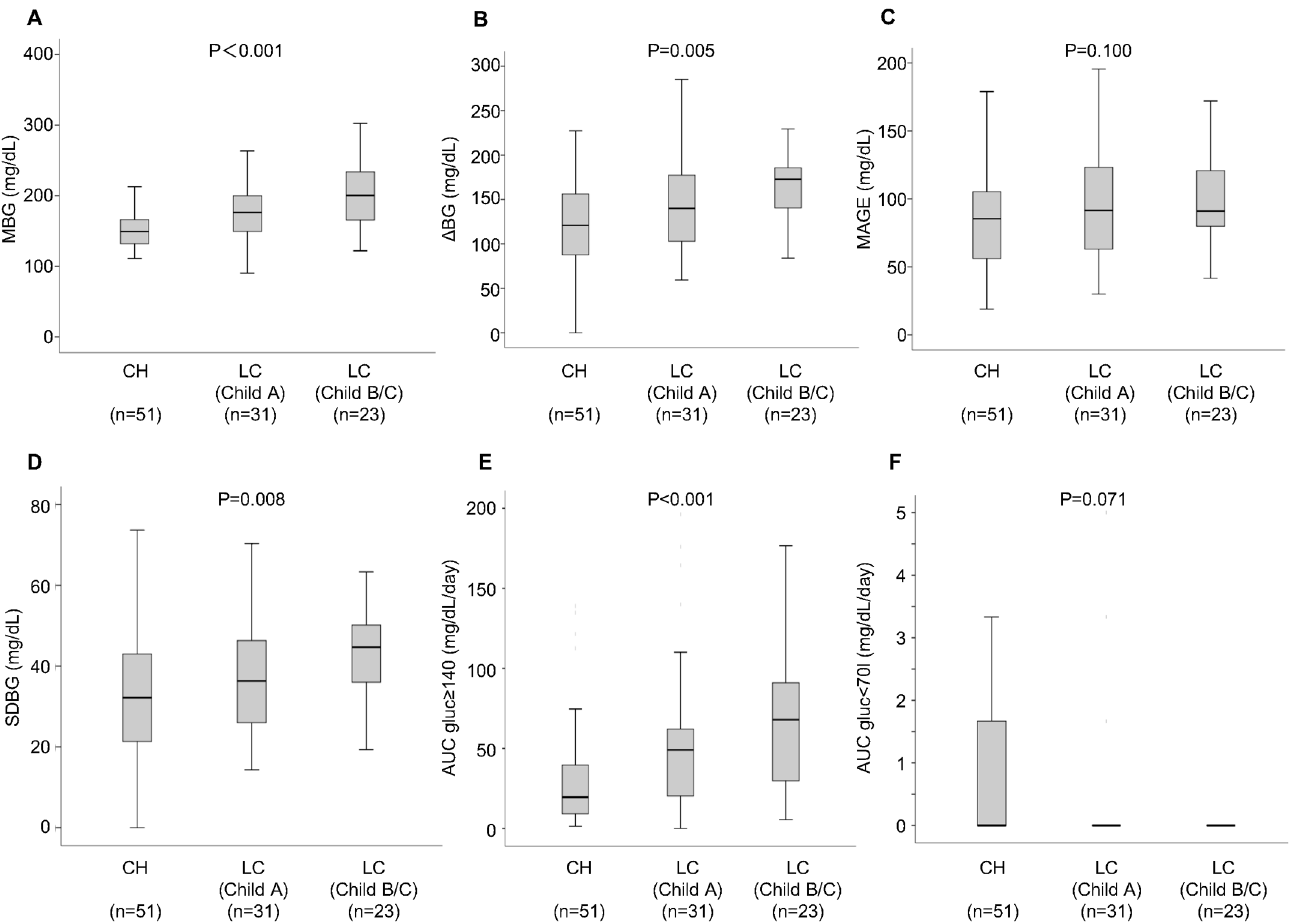
Fig 1. Comparison of CGM parameters in three groups according to liver functional reserve (CH group, Child A group and Child B and C group). (A) Mean blood glucose (MBG), (B) delta change in blood glucose ( Δ BG), (C) mean amplitude of glycemic excursion (MAGE), (D) standard deviation of blood glucose (SDBG), (E) area under the curve of blood glucose above 140 mg/dl, (AUCgluc (cid:21) 140) and (F) area under the curve of blood glucose below 70 mg/dl (AUCgluc < 70) according to the severity of background liver disease in patients with chronic hepatitis (CH), Child-Pugh grade A and Child-Pugh B and C. In these box-and-whisker plots, lines within the boxes represent median values; the upper and lower lines of the boxes represent the 25th and 75th percentiles, respectively; and the upper and lower bars outside the boxes represent the 90th and 10th percentiles, respectively.